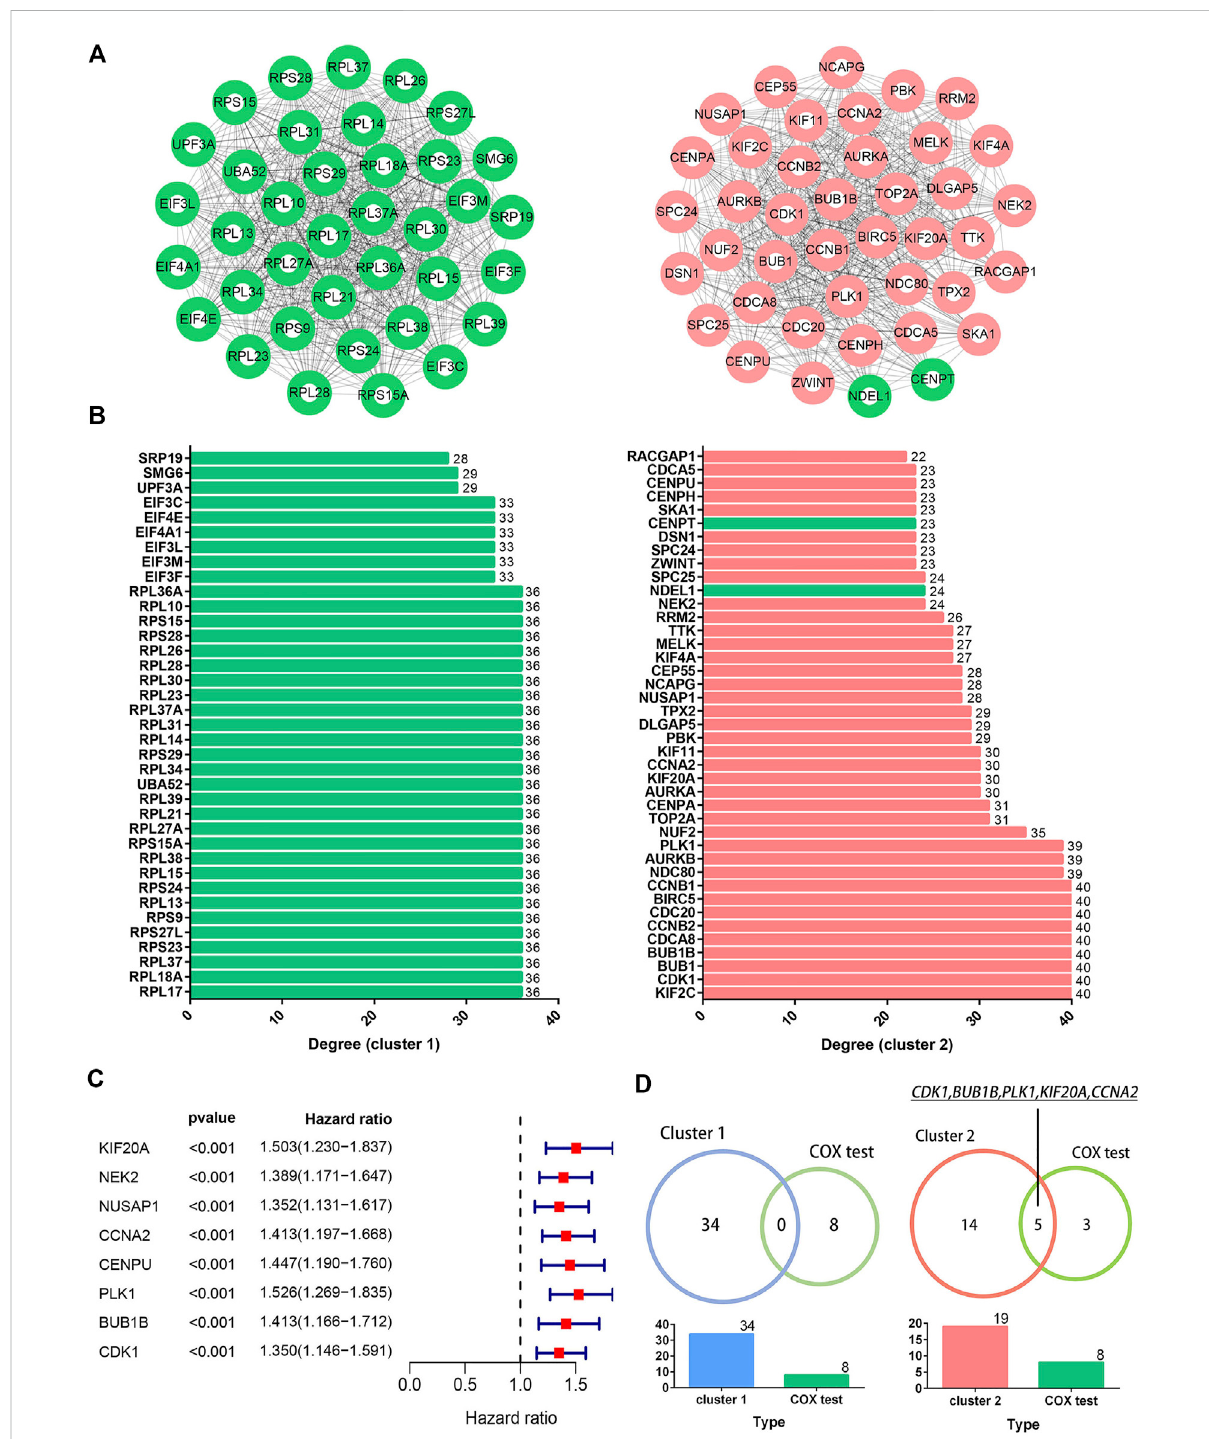
FIGURE 4 Identi fi cation of hub genes. Image (A) illustrates the network of the top two clusters in the protein-protein interaction network containing 904 common DEGs. Green and red colored spots indicate downregulated and upregulated DEGs, respectively. Image (B) illustrates the degrees of connectivity within the nodes in the corresponding cluster networks. Image (C) shows the results of the univariate COX analysis for the signi fi cant factorsinselectedclusters( p < 0.001).Image (D) showsthe fi vecommongenesoverlappedbythenodeswithconnectivitydegreesabove30in the cluster network (n > 30) and a p -value below 0.001 in the COX